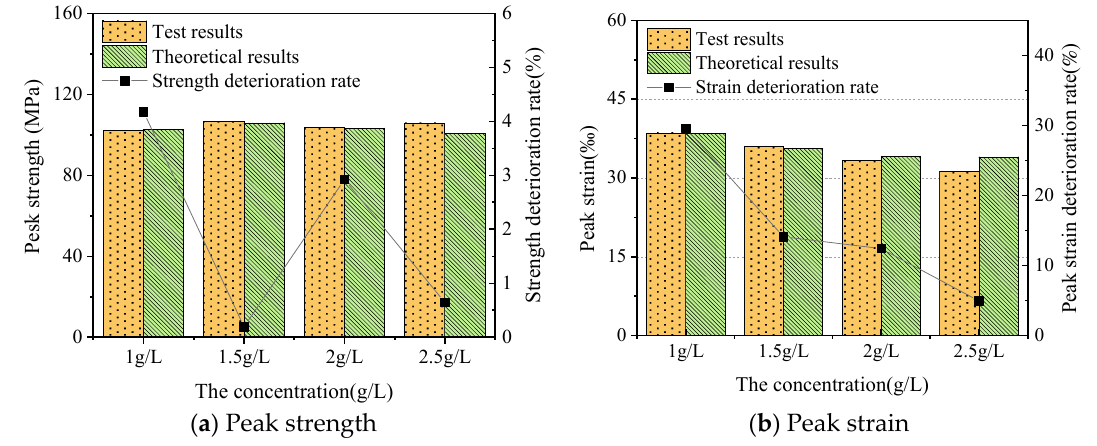
Figure 3. Mechanical parameters and deterioration of the samples.